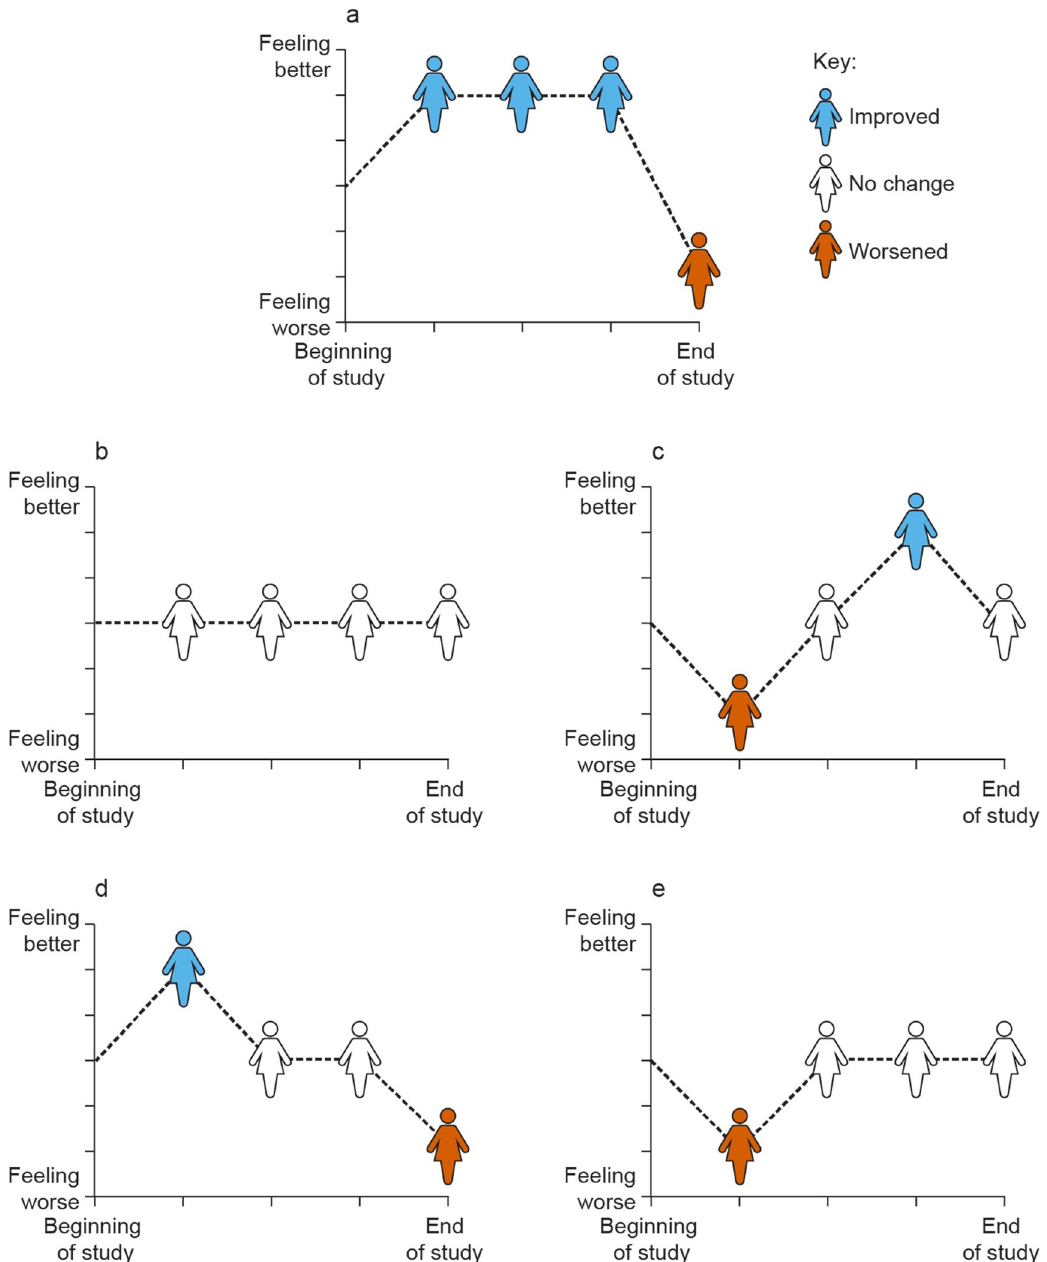
Fig 1. Trial responses for HRQoL. Graphical presentations of hypothetical scenarios showing HRQoL outcomes during a trial: (a) a period of improvement followed by worsening at the end of the trial; (b) no change in HRQoL over the course of the trial; (c) initial worsening followed by improvement and return to baseline; (d) initial improvement, a period of stability on the baseline level, followed by worsening; (e) initial worsening followed by a sustained period of stability at the baseline level.